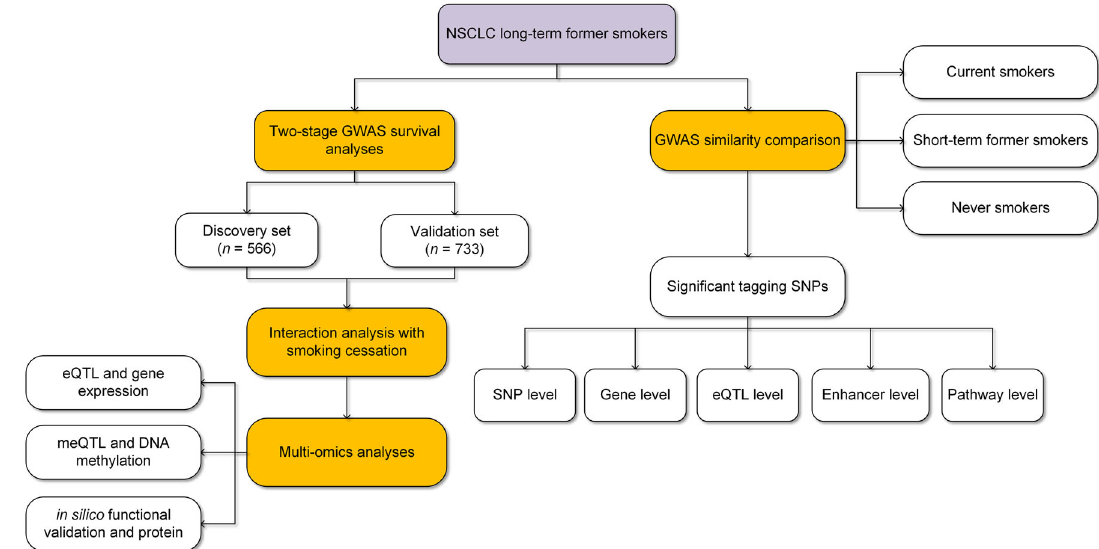
Fig. 5 Study work fl ow. Our study mainly included three parts: (1) GWAS survival study for long-term former smokers; (2) multi-omics study for candidate SNPs and genes; and (3) genetic similarity comparative analysis among different smoking status subgroups.